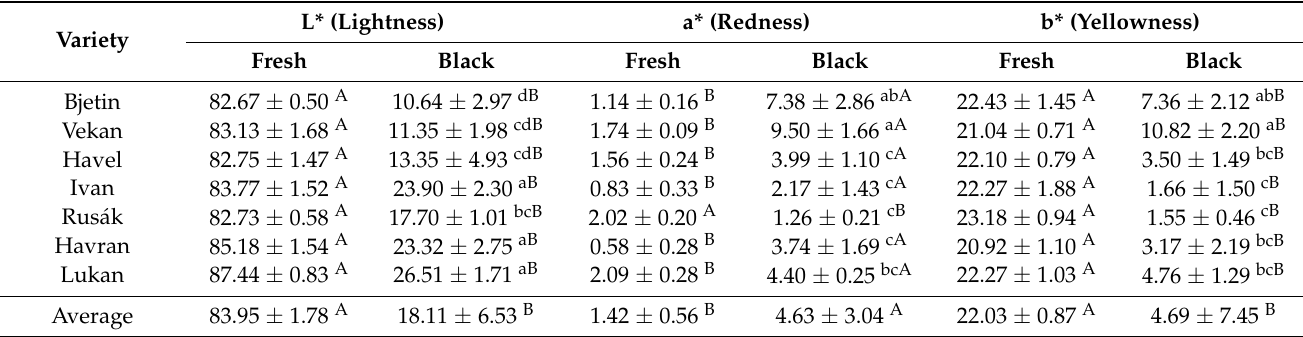
Table 4. Color analysis of fresh and black garlic varieties in the CIE L*a*b* system.